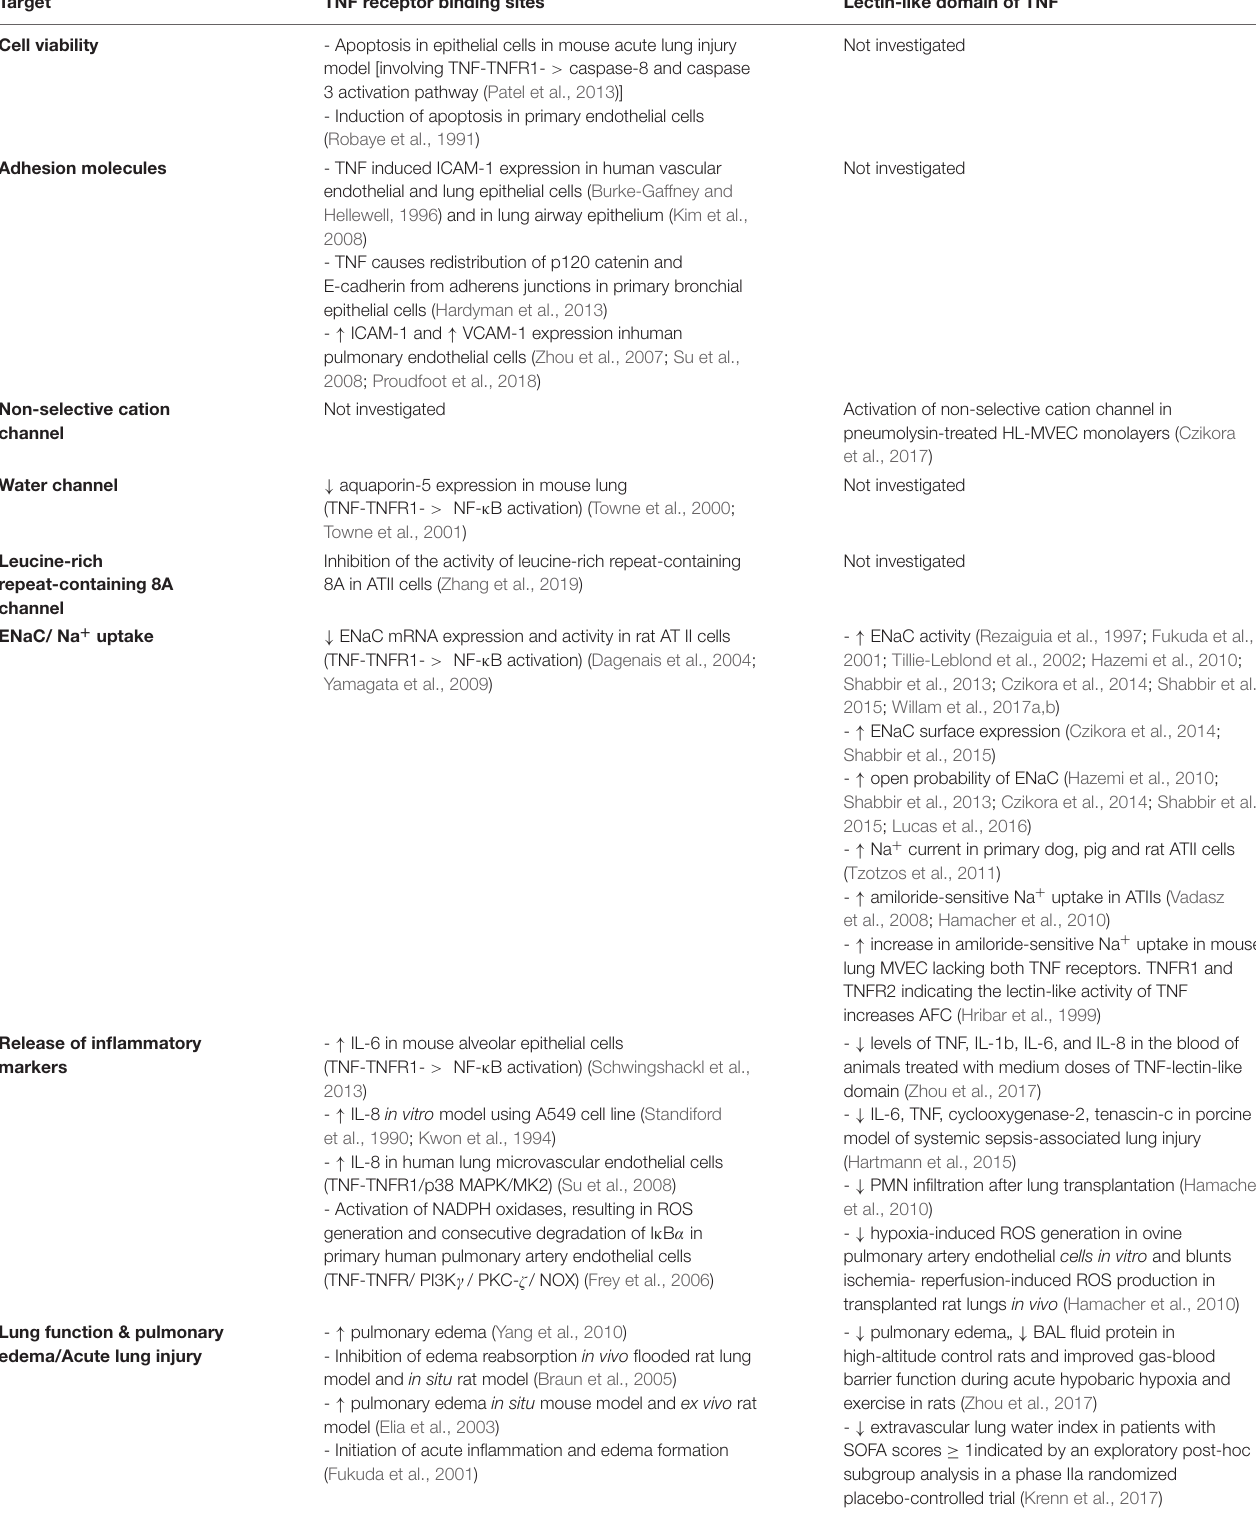
TABLE 2 | Divergent actions of TNF via its receptor binding sites versus its lectin-like domain in the lungs